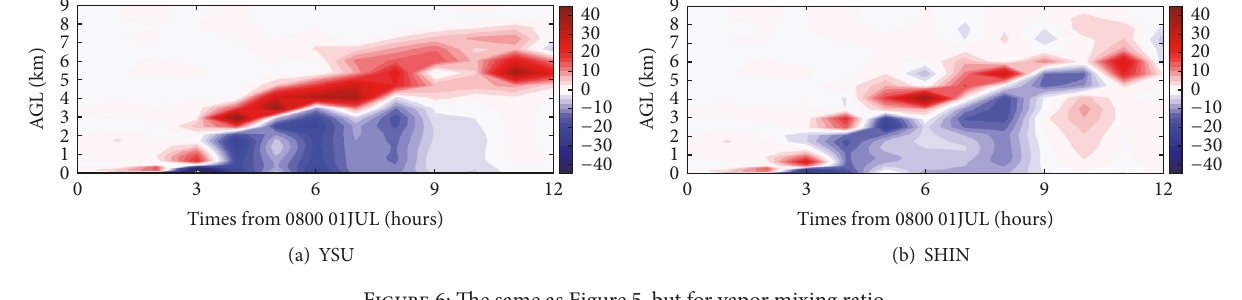
Figure 6: The same as Figure 5, but for vapor mixing ratio.